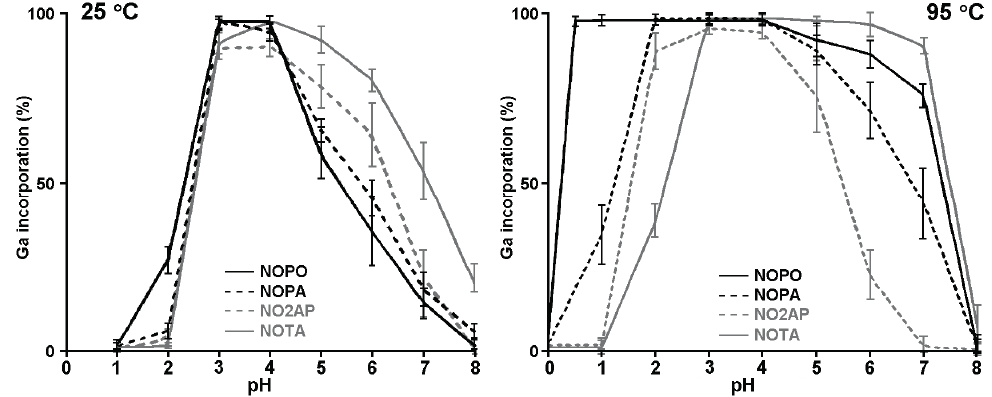
Figure 5. The 68 Ga activity incorporation into the discussed chelators at 25  C and 95  C at different pH values at constant ligand concentrations of 30 and 3 µ M , respectively ( n =